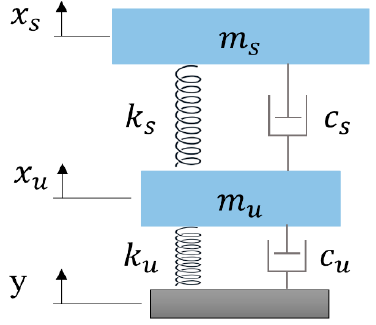
Figure 2. The quarter-car model, adapted from Jazar [29]